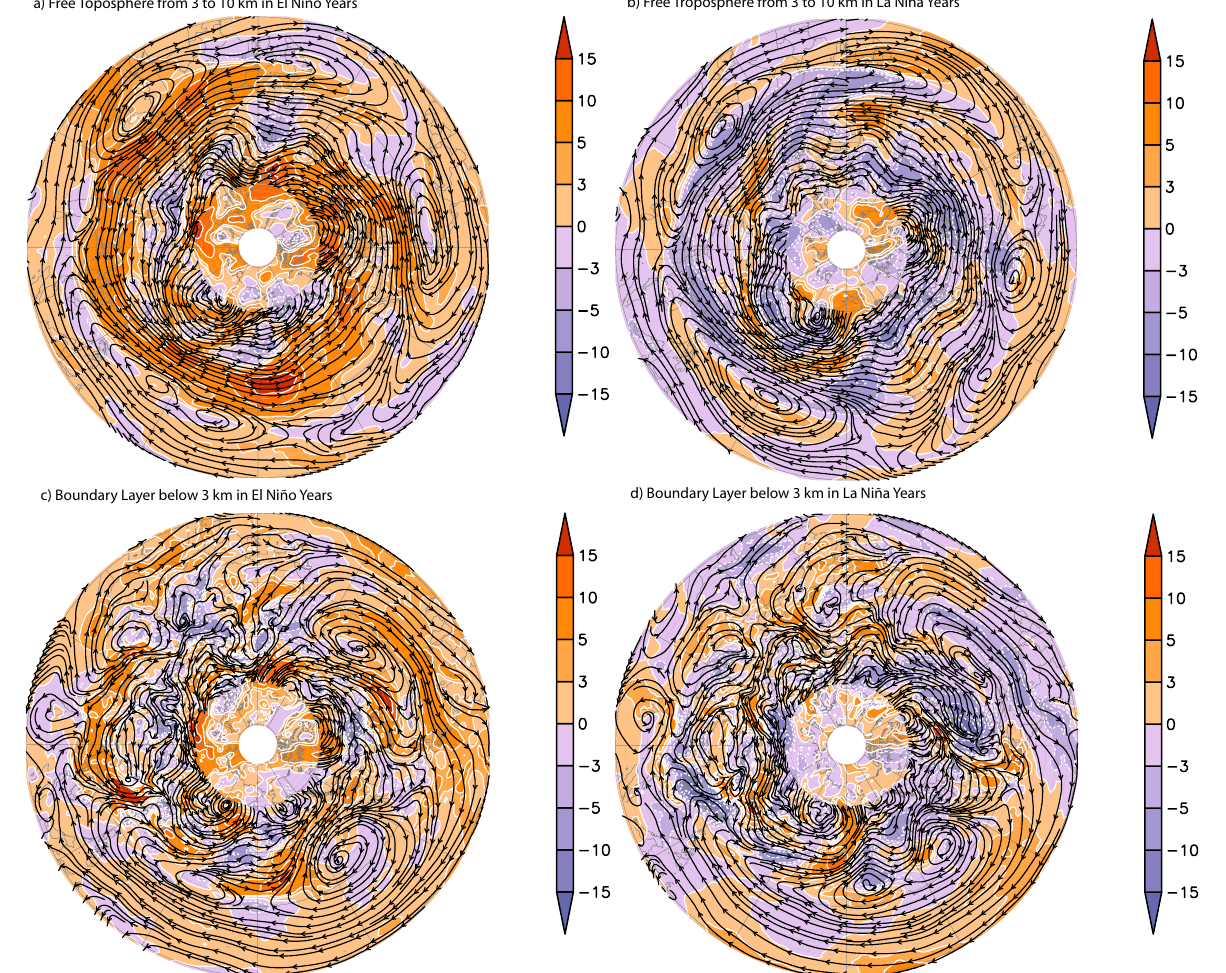
Fig. 11. Anthropogenic aerosol transport fluxes (µgm − 2 s − 1 ; streamlines) averaged in three El Ni˜no years (1995, 1997 and 2003) and three La Ni˜na years (1996, 1999 and 2000) and their anomalies (contours) relative to the 10-yr mean over 1995–2004 in the free troposphere from 3 to 10km and within the boundary layer below